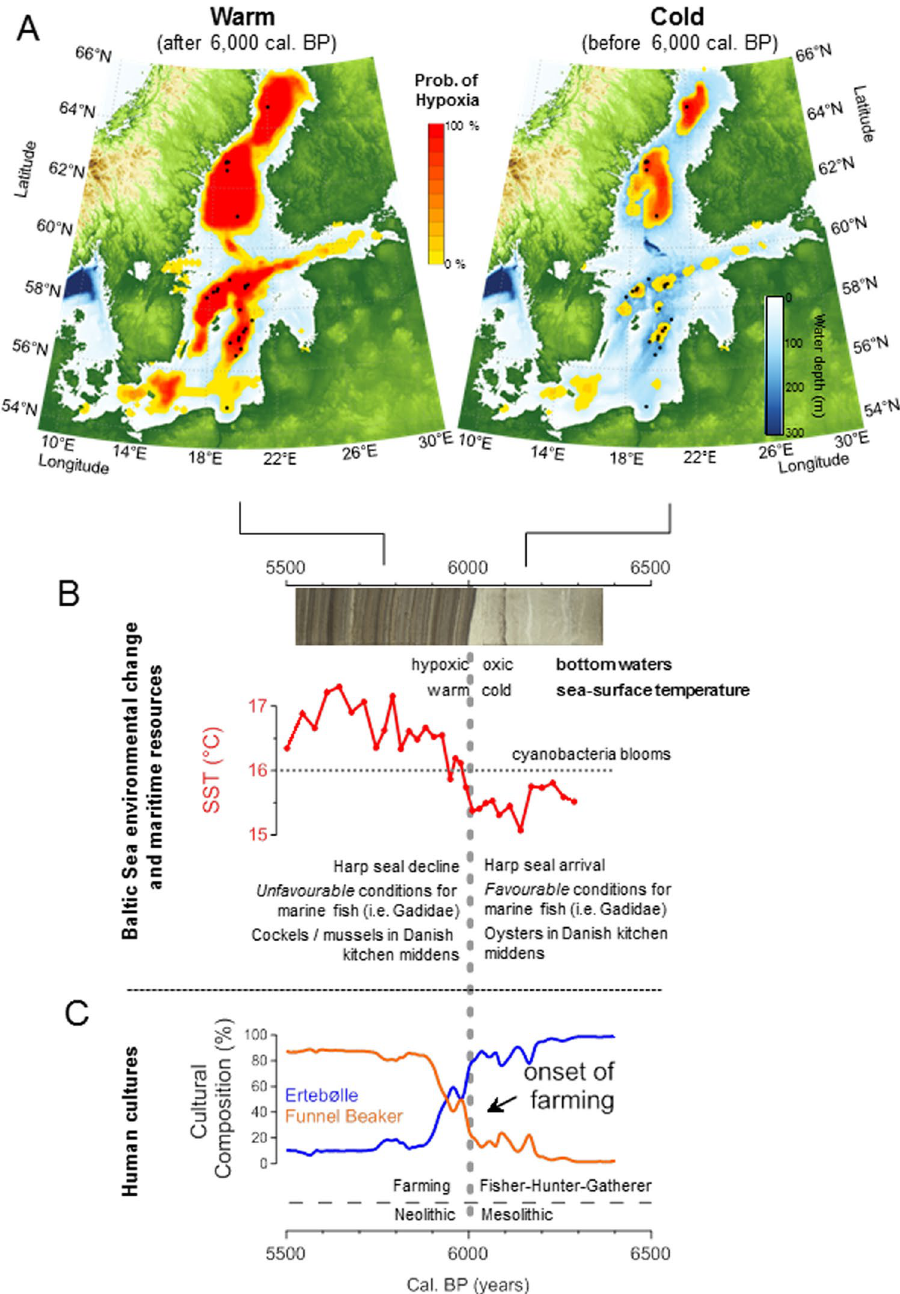
Figure 3. The 6,000 cal. yr BP event: Ecosystem modelling, palaeoclimate and archaeology. Increasing SST after 6,000 cal. yr BP likely improved conditions for farming in the region and thus prompted the migration of the Funnel Beaker culture north. ( A ) Using 3D Ecosystem modelling based on paleobathymetry, the extent of hypoxia in the Baltic Sea is shown for the cold phase (right panel) before 6,000 cal. yr BP and for the warm phase (left panel) after 6,000 cal. yr BP. Note the remarkable spreading of hypoxic areas to the whole basin after 6,000 cal. yr BP, suggesting i) the regional wide scale of the climatic changes and ii) a close relationship between SST rise and spread of anoxia (see SI), which may have had consequences for marine life, therefore affecting the hunter-gatherer-fisher society. ( B ) Regional environmental changes in the Baltic Region at this time. The sequence from non-laminated to laminated sediments along with the significant increase in organic carbon content reveals that the development of anoxic bottom water conditions which is related to the substantial increase in SST. ( C ) Population density based on SPD. Note the population growth rate increases at the boundary between the Meso- and Neolithic. The maps were created using the software package GrADS 2.1.1.b0 (http://cola.gmu.edu/grads/), using published bathymetry data 42,43